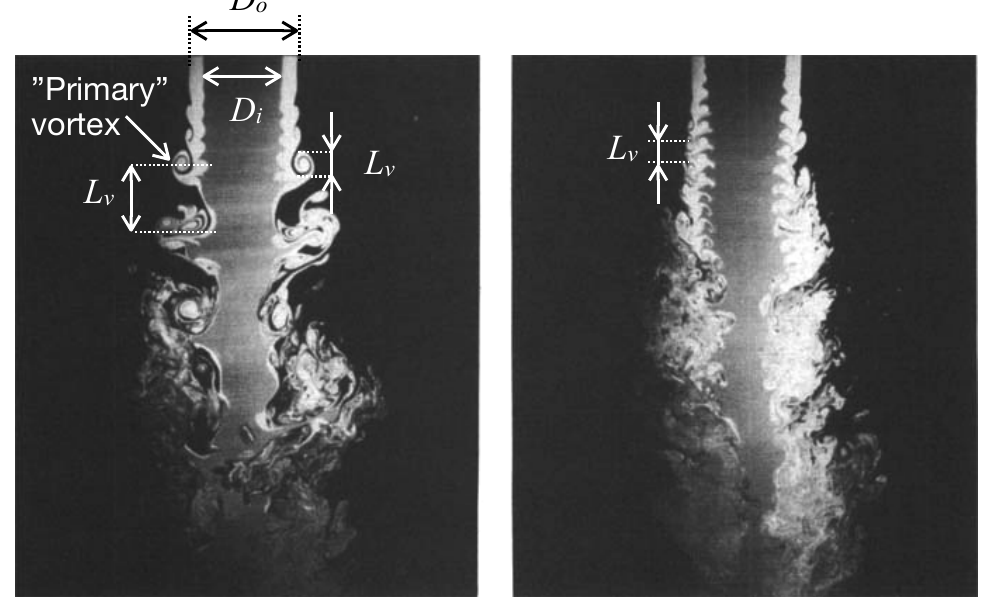
FIGURE 12. Cross-sectional LIF photographs showing the coaxial jet near-field vortex structure for Figure 2. Cross-sectional laser induced fluorescence images of a coaxial jet’s near field flow structure two cases having the same velocity ratio U,/U, = 1.00, but having different absolute velocities. adapted from Dahm et al. [15] (Reprinted with permission). r u = 1.00 in both images; absolute Note that, owing to the larger amplification rates for the wake instability of the inner layer in (b), velocities are about twice as high in the right picture. Note that L v denotes a characteristic length the wake vortices that form and their interaction with the shear-layer vortices formed from the scale that is either the vortex spacing or the vortex size (see Section outer layer produce a dramatically different near-field structure from that seen in (a).